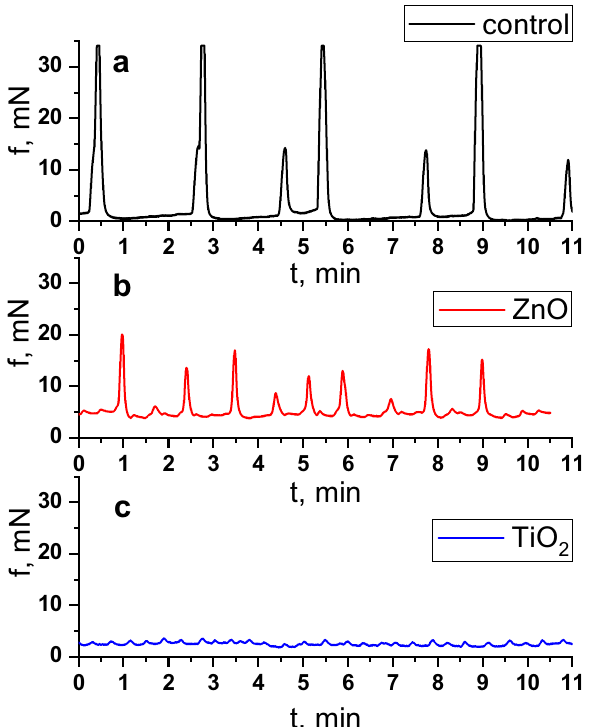
Figure 1. Spontaneous contractile activity of the circular SMs of the antrum of rats: ( a) control group; ( b ) and ( c ) groups of rats burdened for 6 months with ZnO and TiO 2 ANs, respectively.